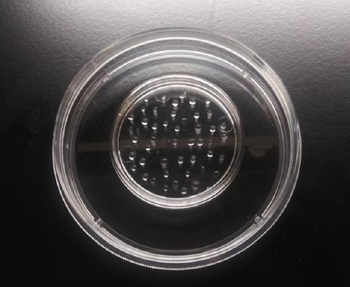
Figure 2. A plastic coupon inoculated with 100 µ L of inoculum dispensed into concentric circles of approximately 50 beads containing 2 µ L each. Note this photo was taken before the inoculum was